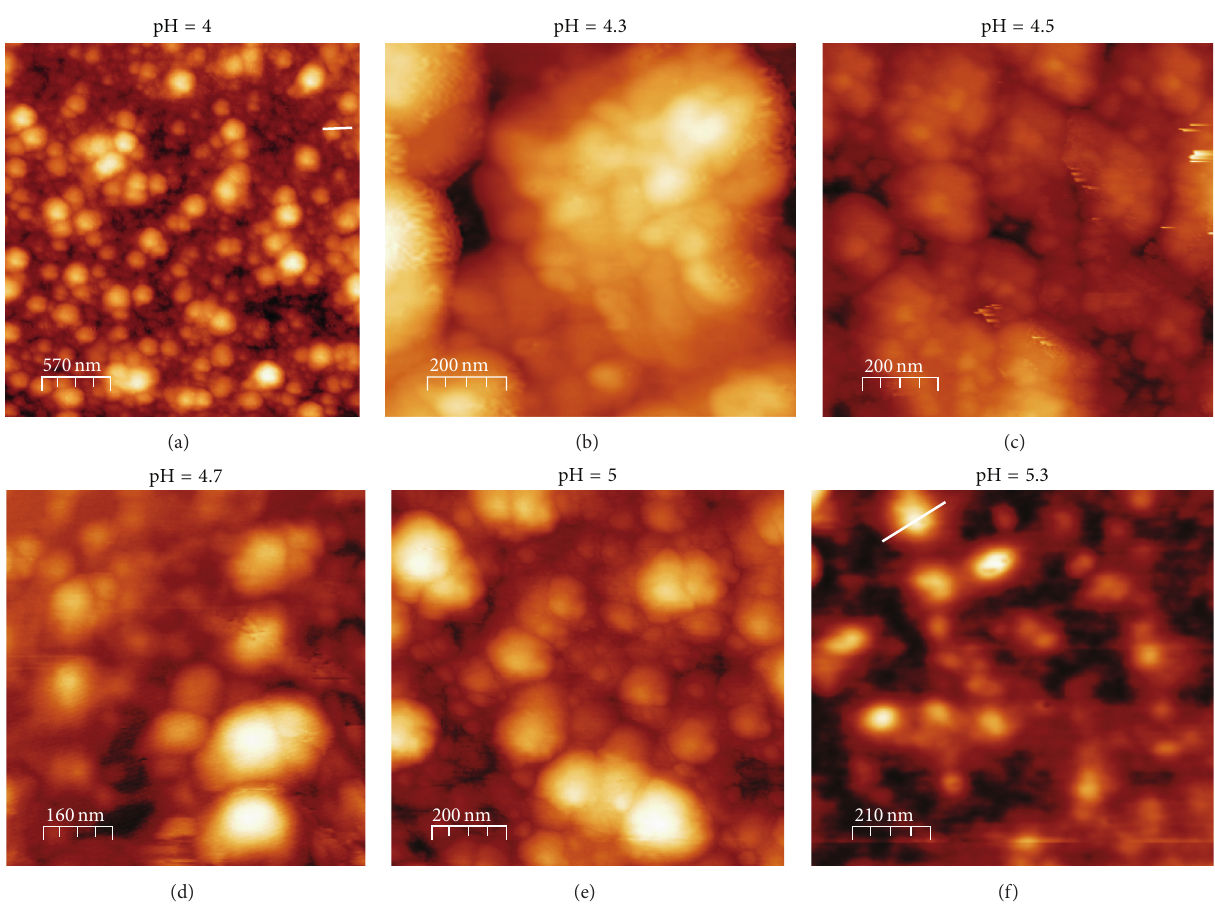
Figure 8: AFM of morphology evolution of thiolated chitosan